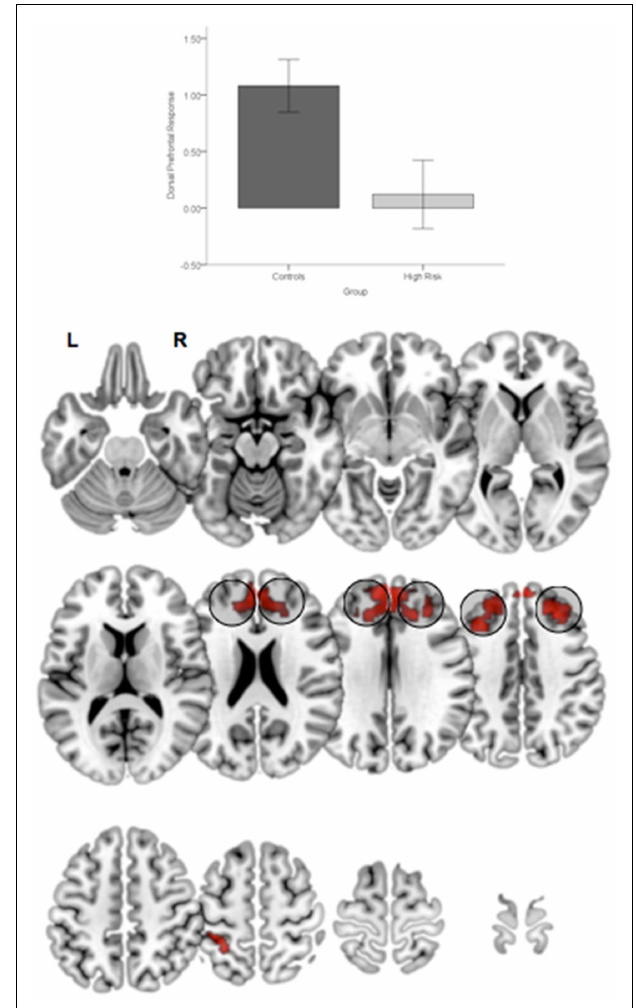
FIGURE 4 | Significant ( p < 0.05, cluster level) bilateral clusters in the dlPFC and dmPFC (insets) under the overall main effect of group in the activation analyses represent significant hypo-engagement of the structure in HGR compared toTC (graph of parameter estimates from the peak in the dlPFC) .The clusters are rendered on an ascending mosaic of axial surfaces.These results imply significant hypo-engagement of the prefrontal cortex in HGR during sustained